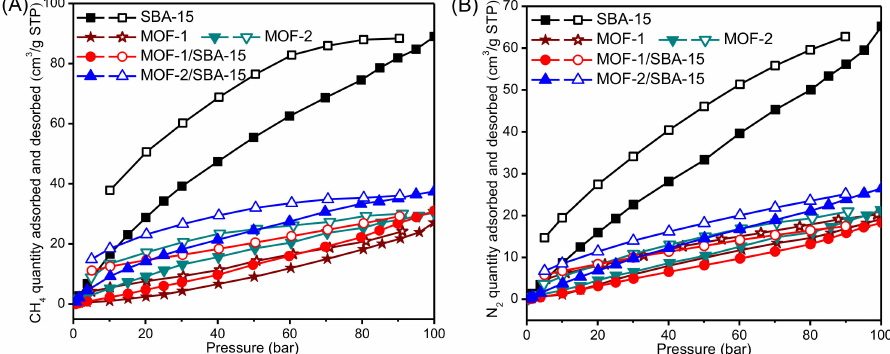
Figure 6. Adsorption and desorption equilibrium isotherms of CH 4 ( A ) and N 2 ( B ) for the